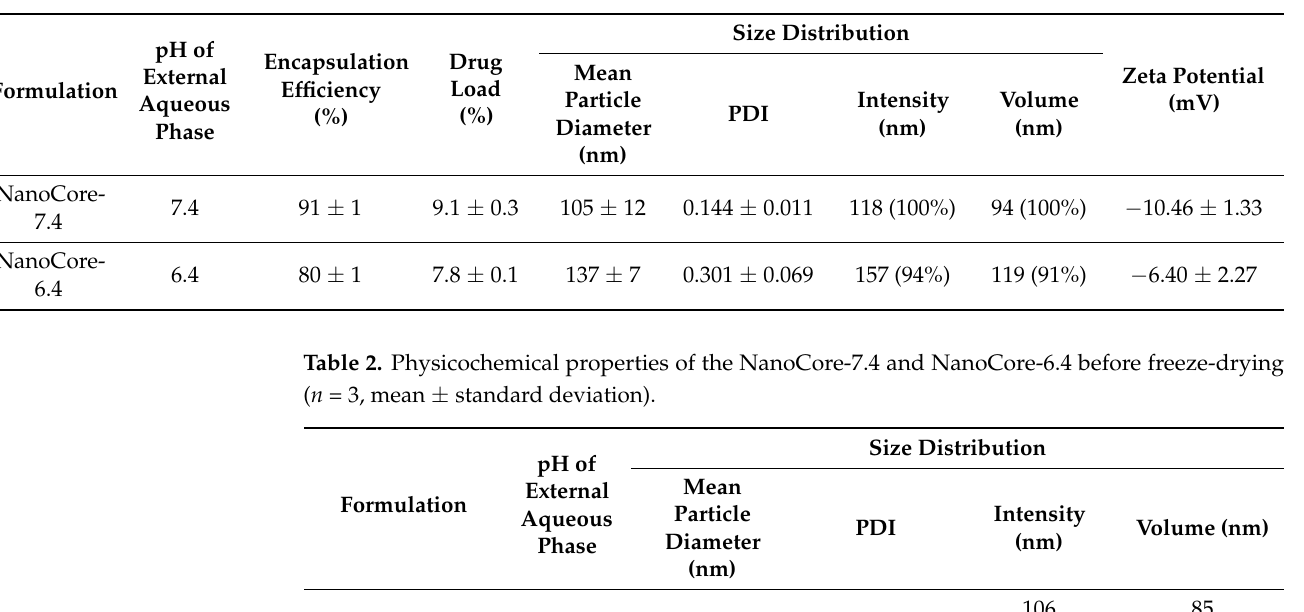
Table 1. Physicochemical properties of the NanoCore-7.4 and NanoCore-6.4 after freeze-drying ( n = 3, mean ± standard deviation).